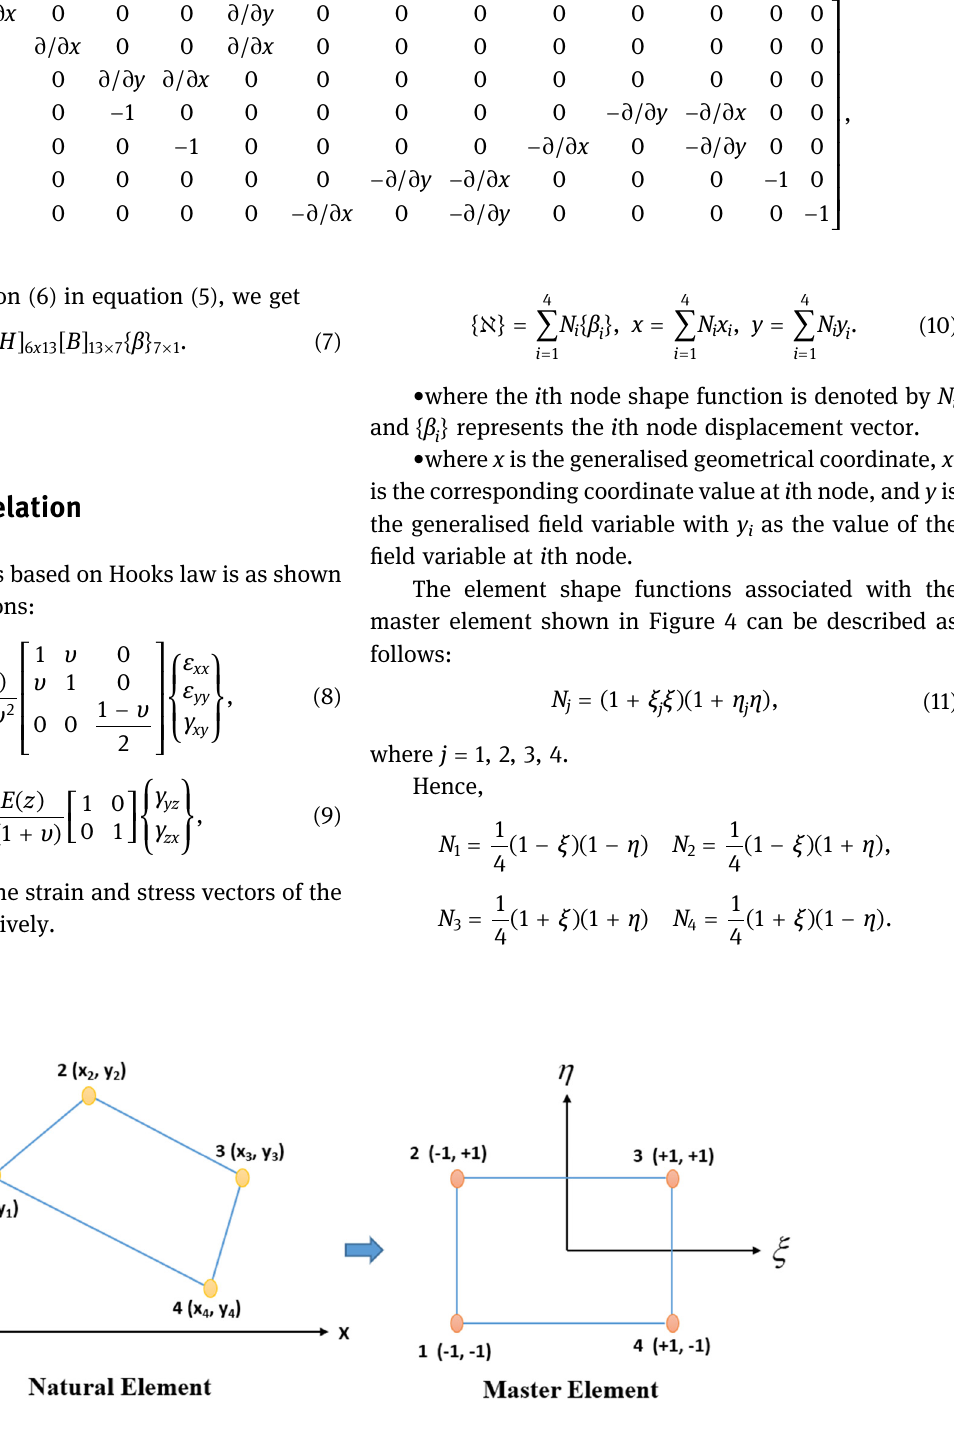
Figure 4: Four - noded fi nite element con fi